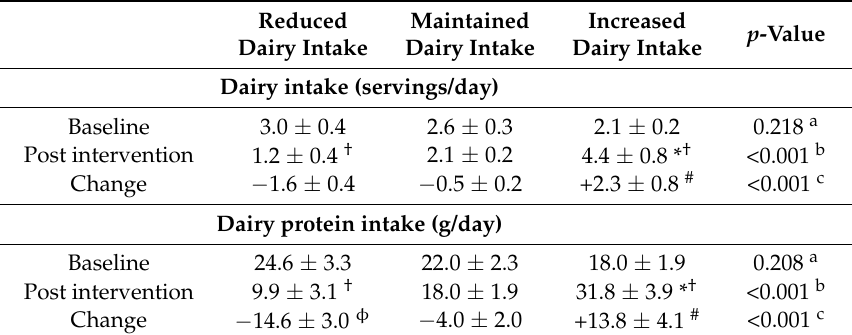
Table 2. Changes in dairy intake and dairy protein intake for each randomized group throughout the intervention